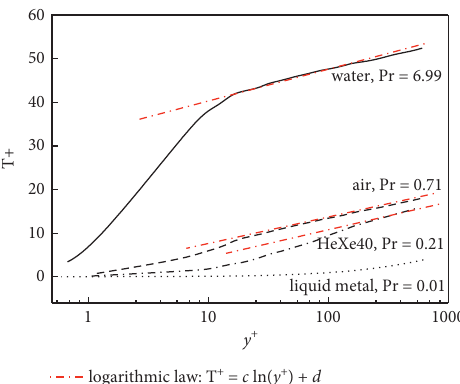
Figure 12: Temperature profiles of various fluids.